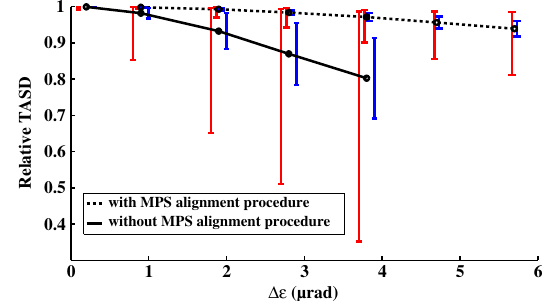
FIG. 9. Statistical distribution of the relative TASD as a function of MPS parallelism (see Appendix B) with 5000 events per point. The configurations are simulated with the fast M ATLAB code [39] described in Sec. IV C. The points connected by a dashed (solid) line describe the average relative TASD of the data with (without) the MPS alignment procedure. The error bars on the left of each point represent the extreme events of the data and the error bars on the right of each point represent the